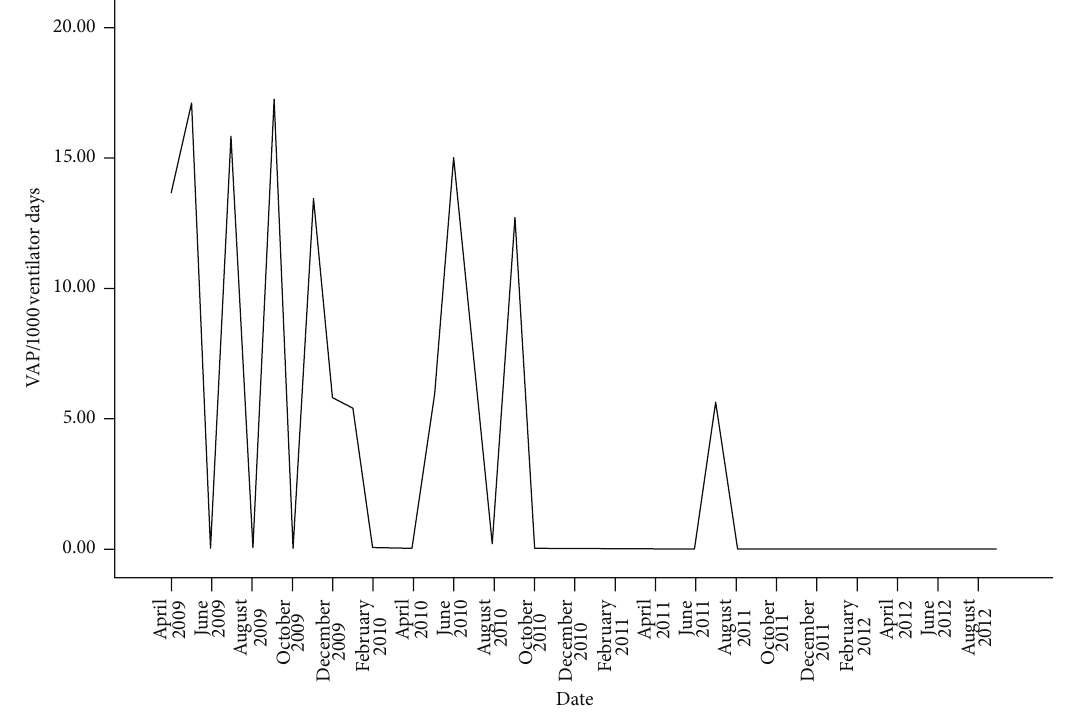
Figure 1: Time series plot of the ventilator-associated pneumonia rate from April 2009 to September